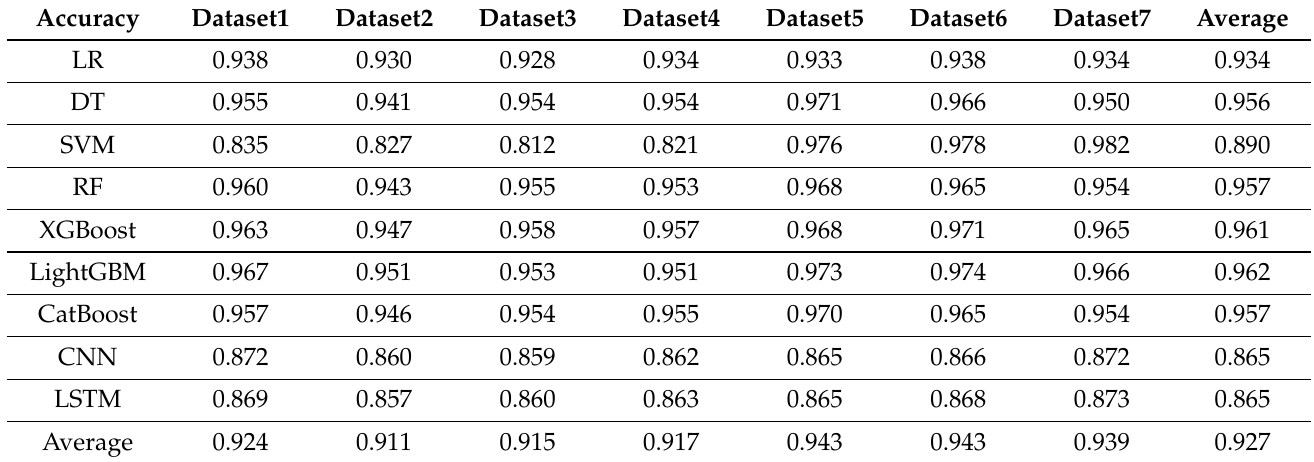
Table 12. Testing accuracy of the best model.